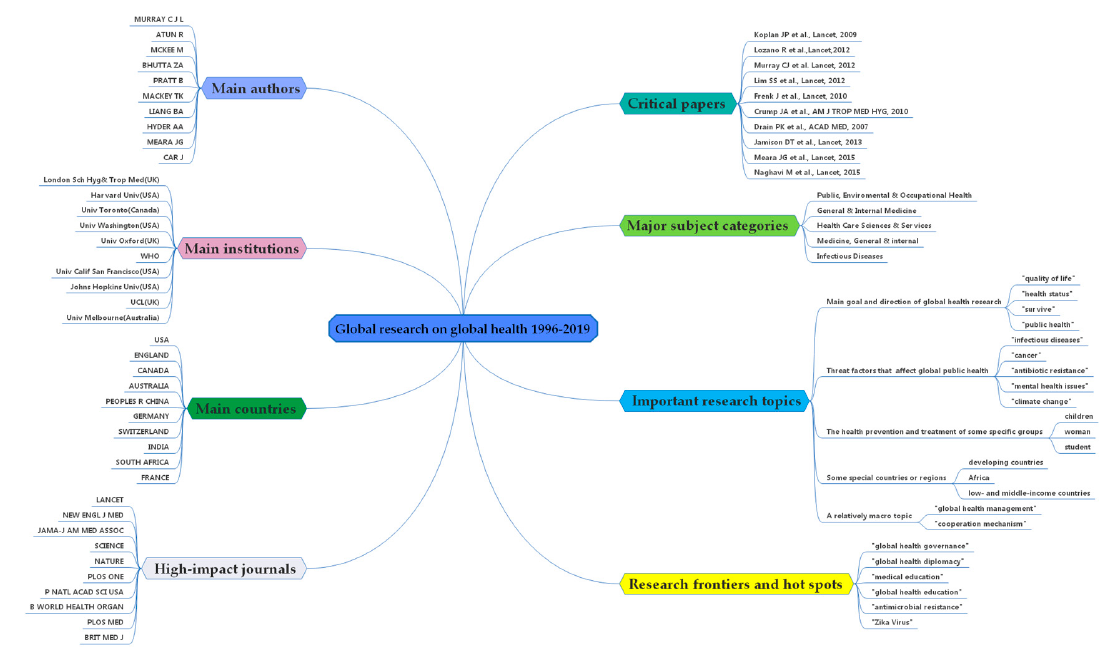
Figure 10. A comprehensive knowledge map in the global health research field: